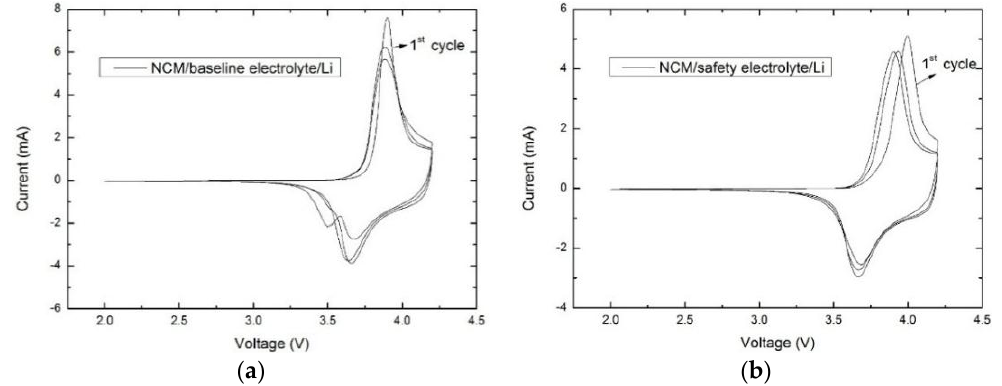
Figure 6. Cyclic voltammograms (CV) of NCM/Li half cells with different electrolytes: ( a ) NCM/baseline electrolyte/Li; and ( b ) NCM/safety electrolyte/Li.